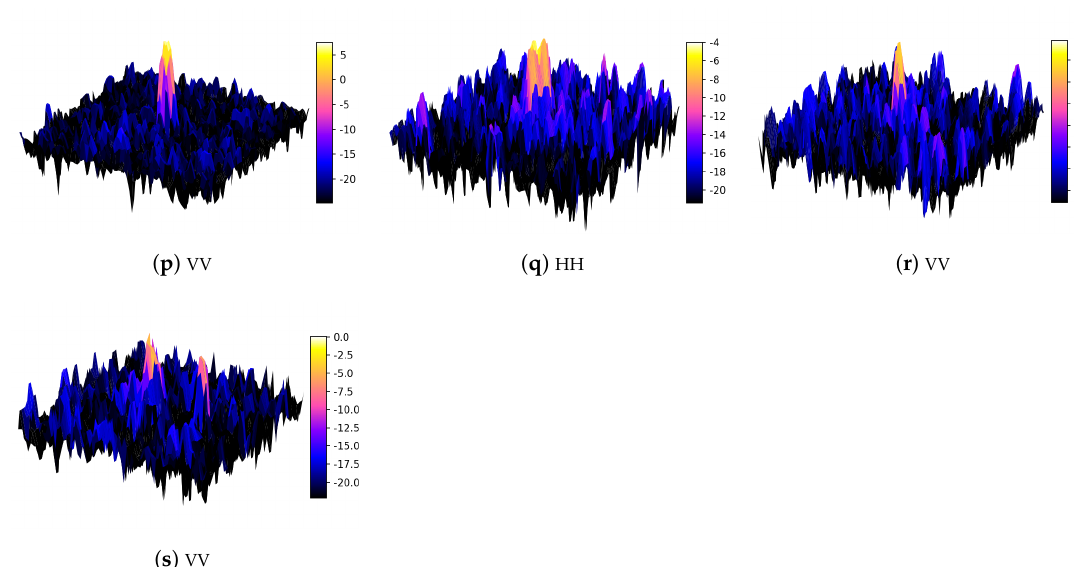
Figure 9. 3D representations of the vessel’s radar footprint in TSX-SM mode (©DLR, 2017) with indications for polarization and special scene or sensor settings.